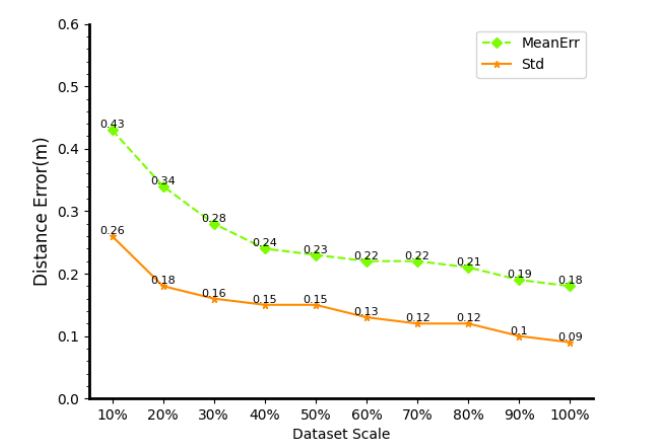
Figure 11. Performance in different scales of dataset scale.